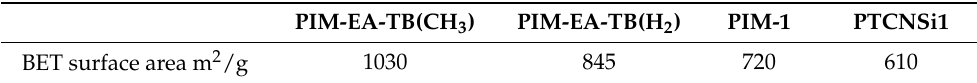
Table 1. BET surface values for the discussed